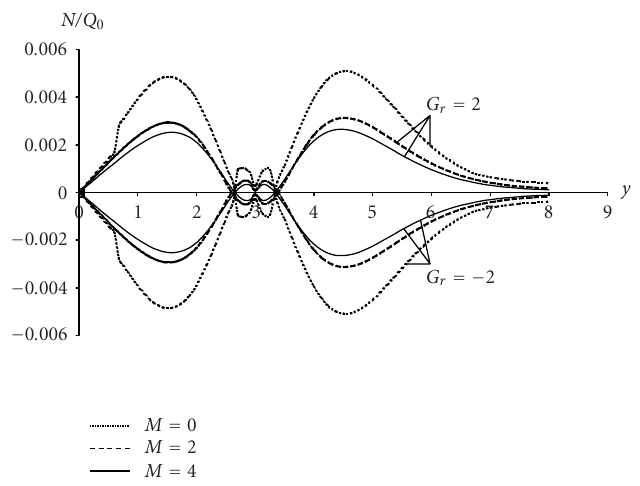
Figure 7.9. The angular velocity distribution for di ff erent values of M for the semispace problem.